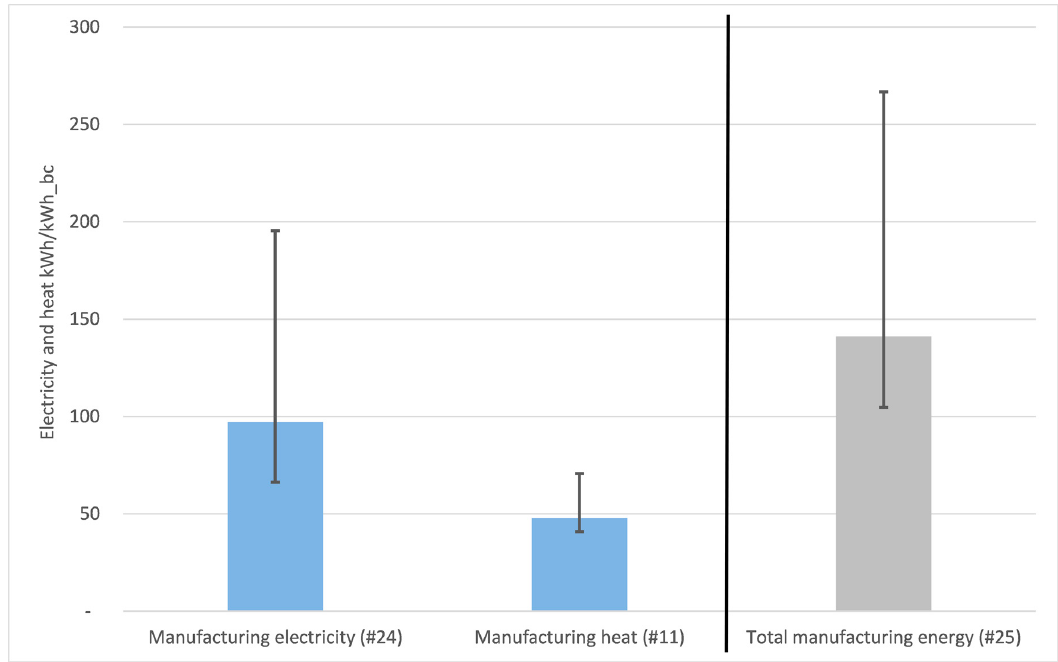
Figure 7. Battery cell manufacturing energy consumption (results based on median, 25%-quantile, and 75%-quantile).